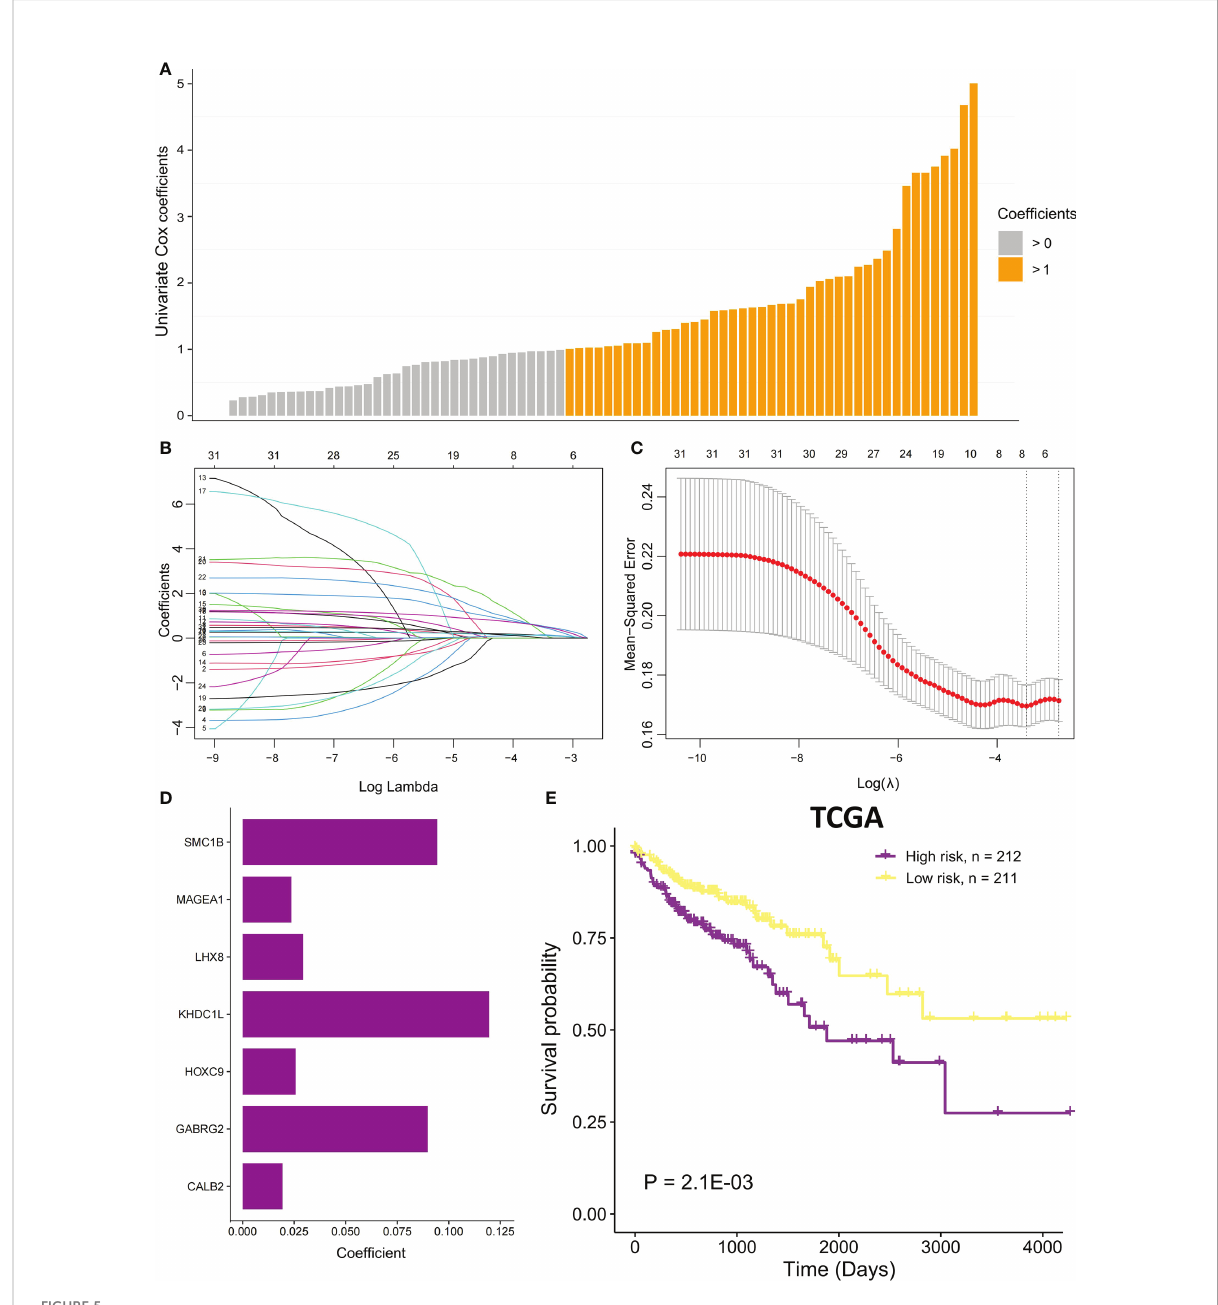
FIGURE 5 The MSI-related prognostic model construction. (A) Univariate Cox proportional regression analysis was conducted to identify signi fi cant MSI- related co-expression prognostic genes with P < 0.01. The bars mean coef fi cients of univariate Cox proportional regression analysis. (B) LASSO coef fi cient pro fi les of 78 MSI-related co-expression prognostic genes. (C) Cross-validation for tuning parameter selection in LASSO model. (D) The coef fi cients of seven MSI-related co-expression prognostic genes in the predictive model were caluclated. (E) In TCGA COAD cohort, OS difference among the two risk samples was evaluated using a log-rank test. Samples of high risk group: 212. Samples of low risk group: